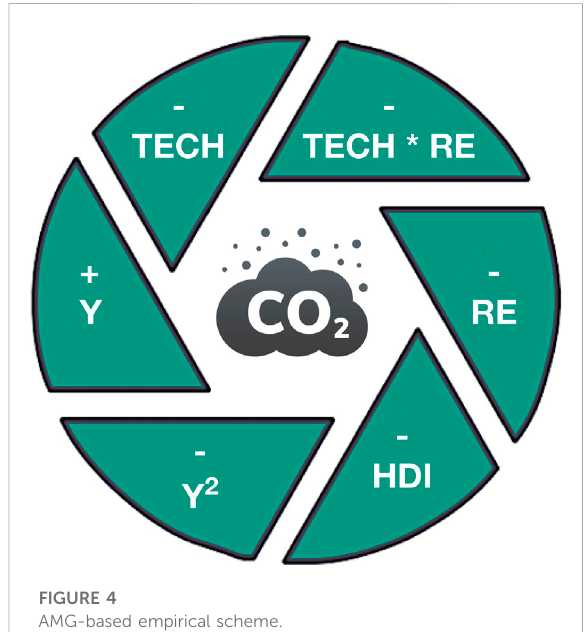
FIGURE 4 AMG-based empirical